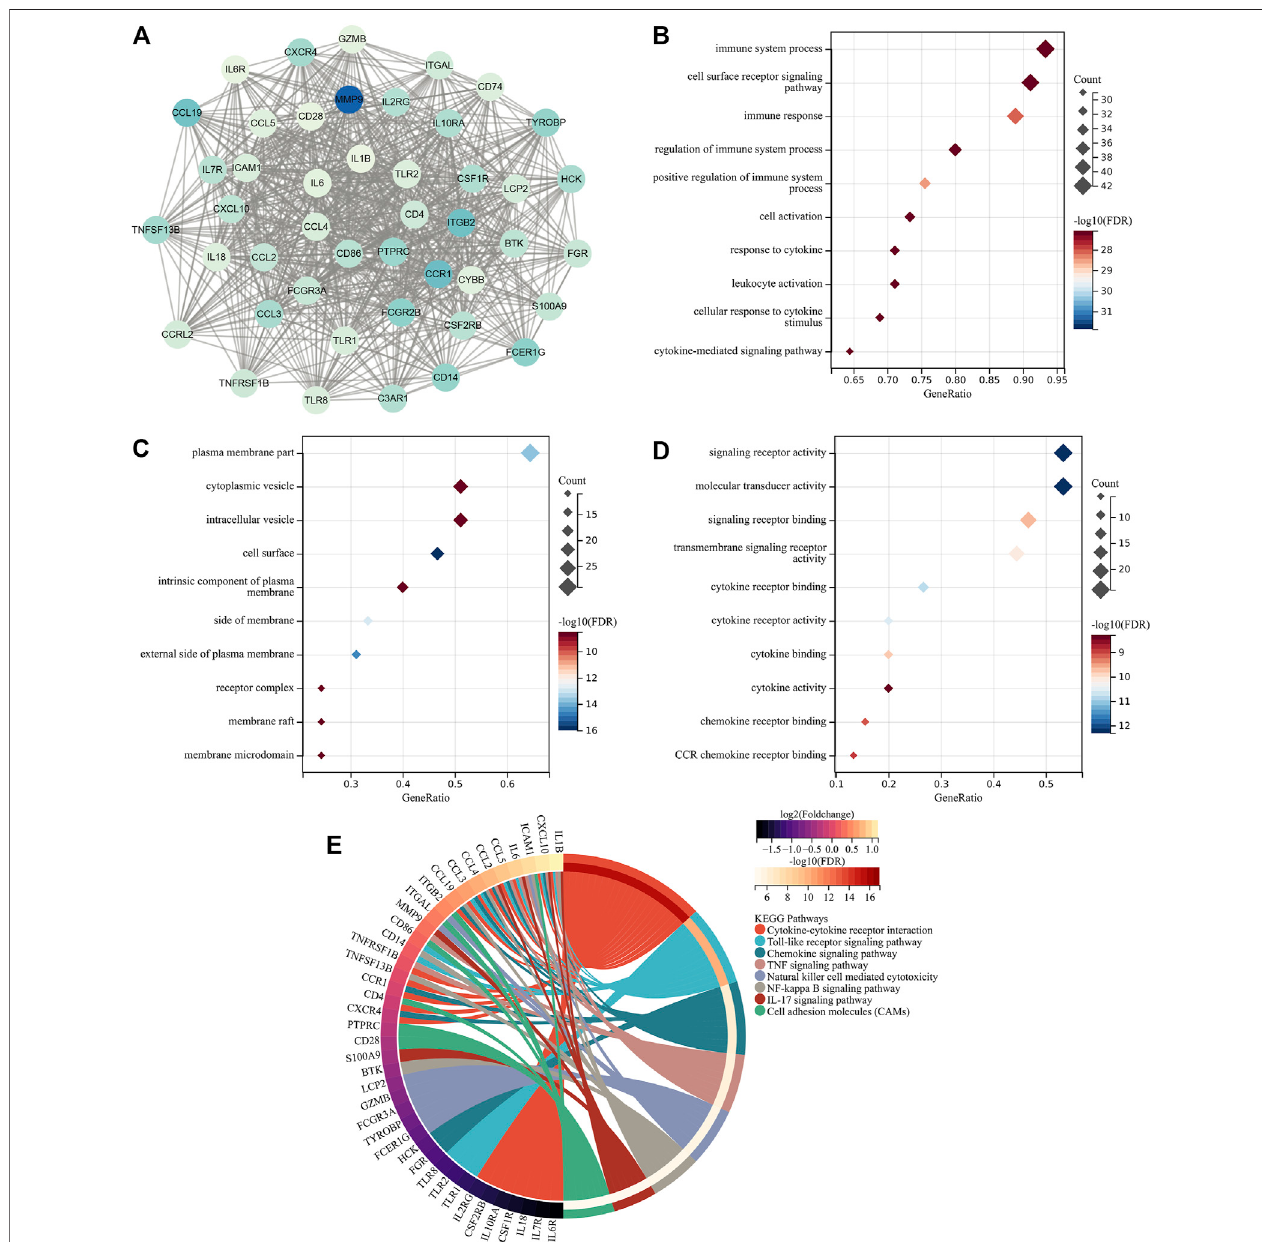
FIGURE 2 | Identi fi cation of key atherosclerotic plaque progression- and immune-associated genes. (A) MCODE analysis identi fi es the hub module from the PPI network of atherosclerotic plaque progression- and immune-associated genes. (B – D) Main BPs, CCs, and MFs enriched by key atherosclerotic plaque progression- and immune-associated genes. (E) Main KEGG pathways enriched by the aforementioned